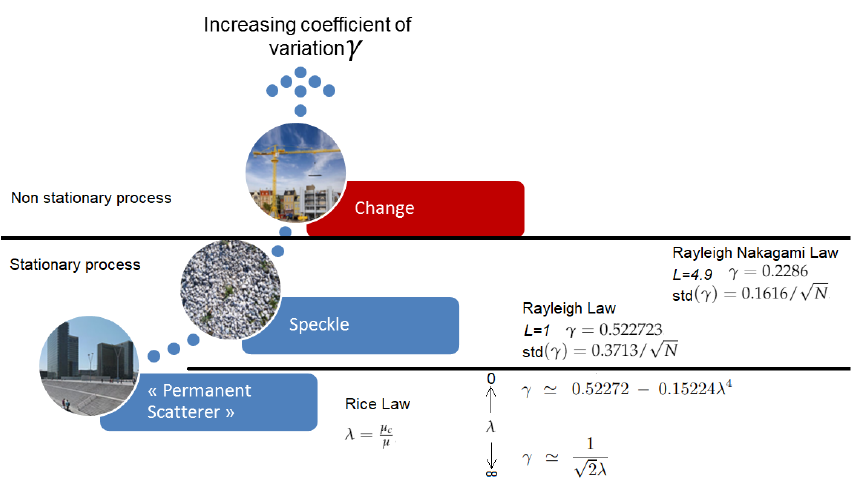
Figure 1. Three generic cases in temporal profiles with increasing coefficient of variation: the deterministic stable class, the natural non-deterministic speckle class, and signal containing radiometric